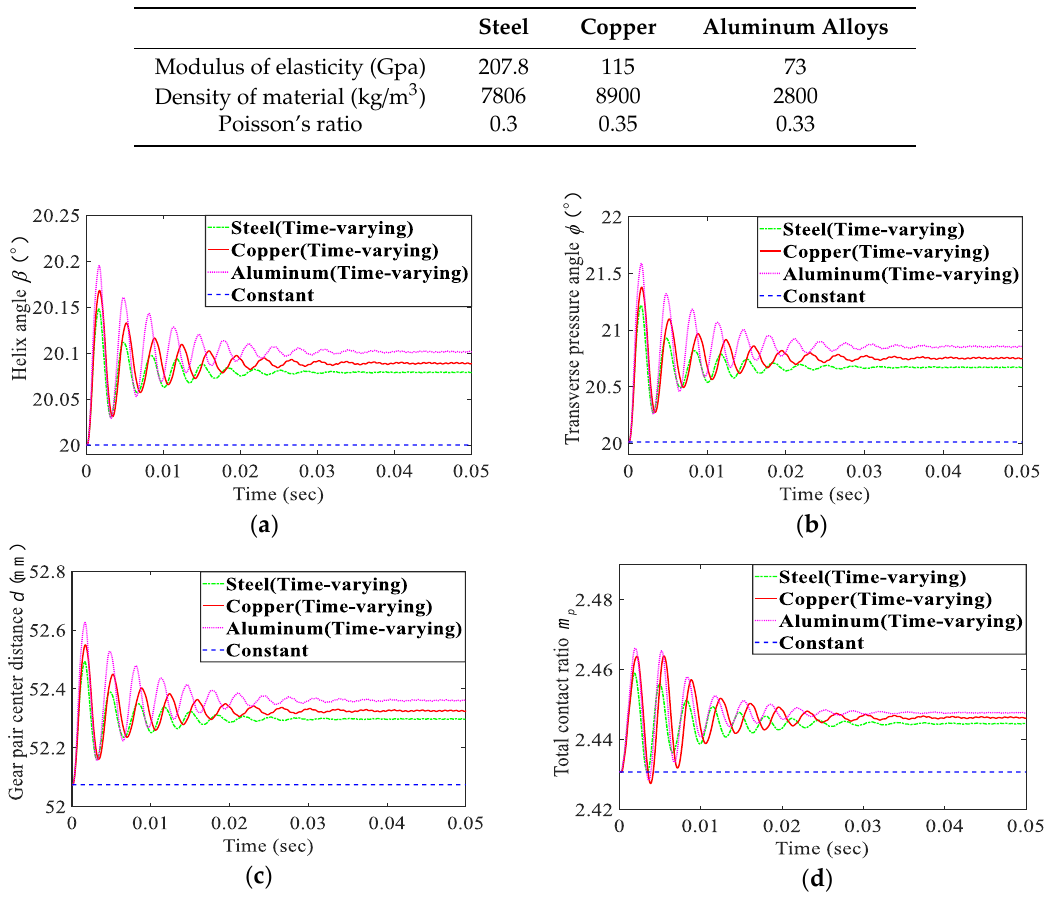
Figure 7. Time-varying and constant ( a ) helix angle, ( b ) transverse pressure angle, ( c ) gear pair center distance, and ( d ) total contact ratio under di ff erent rotating